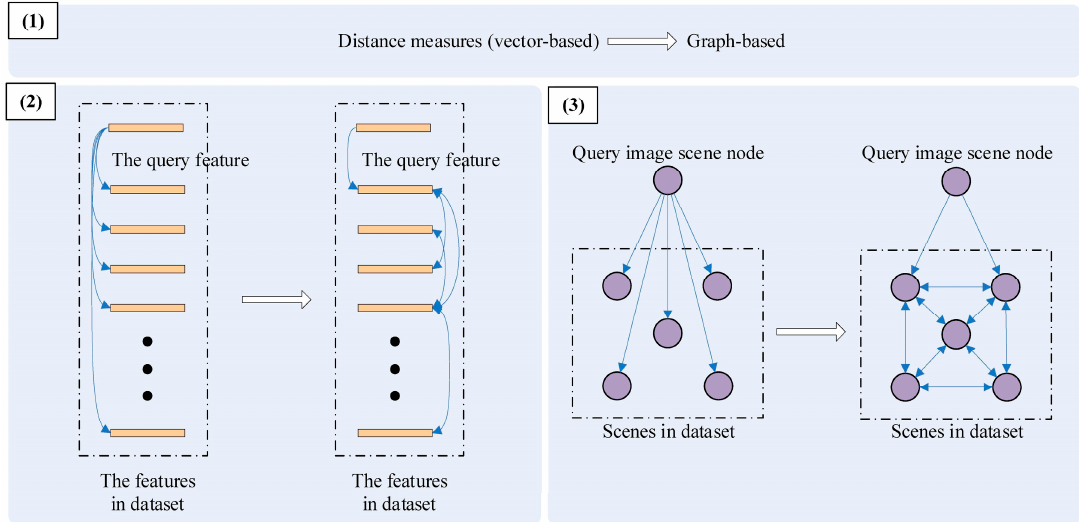
Figure 4. Schematic diagrams of distance measures and graph-based measures. The picture on the left is the principle of feature-level retrieval, and the picture on the right is the principle of scene-level retrieval. A one-way arrow indicates similarity matching between the query scene or corresponding feature and the dataset scene or corresponding feature. Two-way arrows indicate there exists transmission of information between scenes or scenes features, so the scenes in the dataset aren’t feature-level